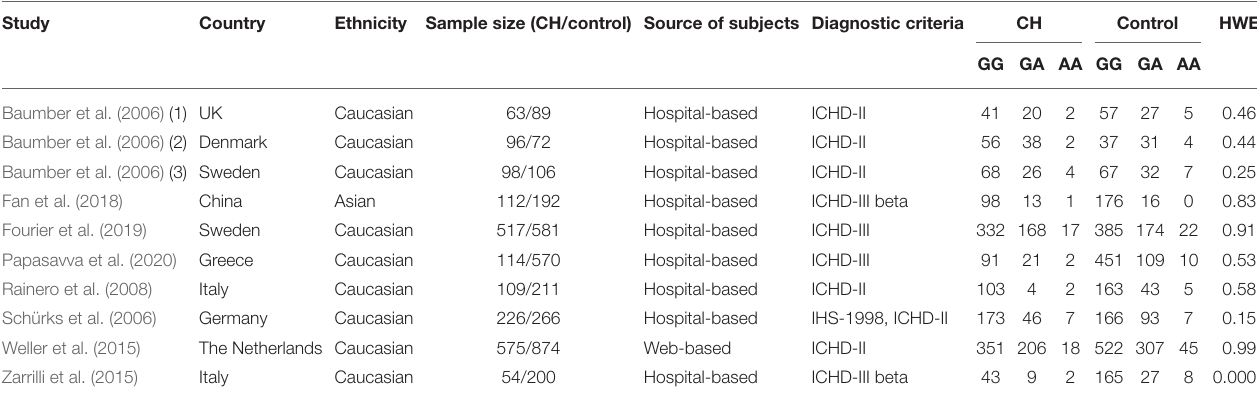
TABLE 1 | Main characteristics of included